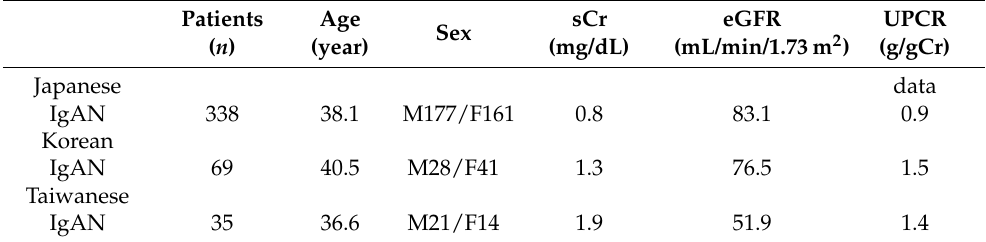
Table 3. Clinical features of patients with IgAN at the time of renal biopsy.